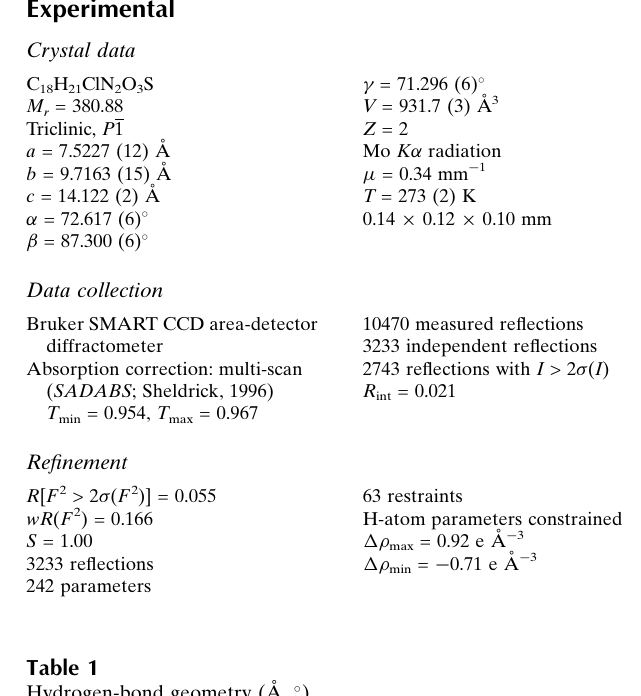
Hydrogen-bond geometry (A˚ , (cid:2)